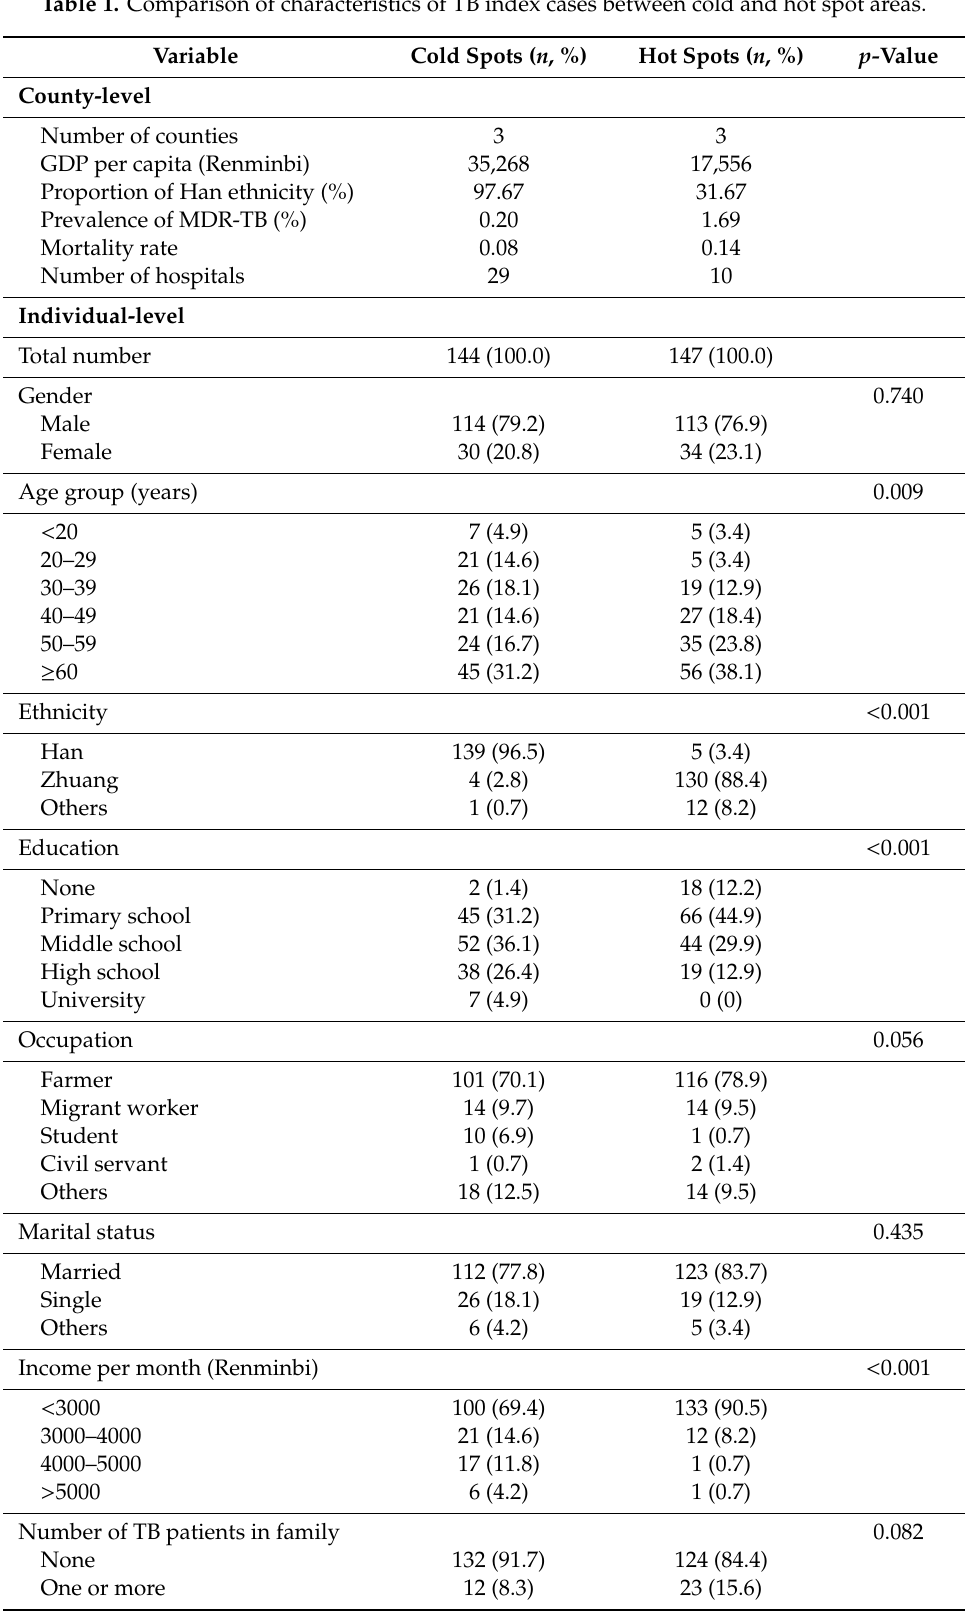
Table 1. Comparison of characteristics of TB index cases between cold and hot spot areas. Variable Cold Spots ( n , %) Hot Spots ( n , %) p-